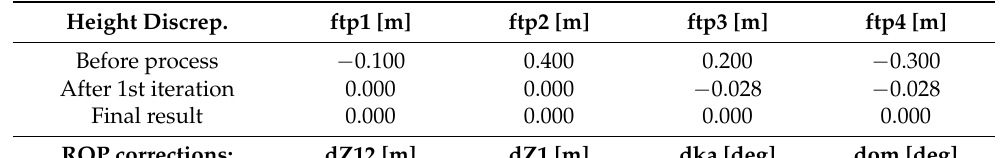
Figure 6. The synthetic data with four GCPs (red) and 21 check points (green). Table 1. Height discrepancies of single segment of synthetic data before, during and after the process and ROP corrections of the lidargram model.